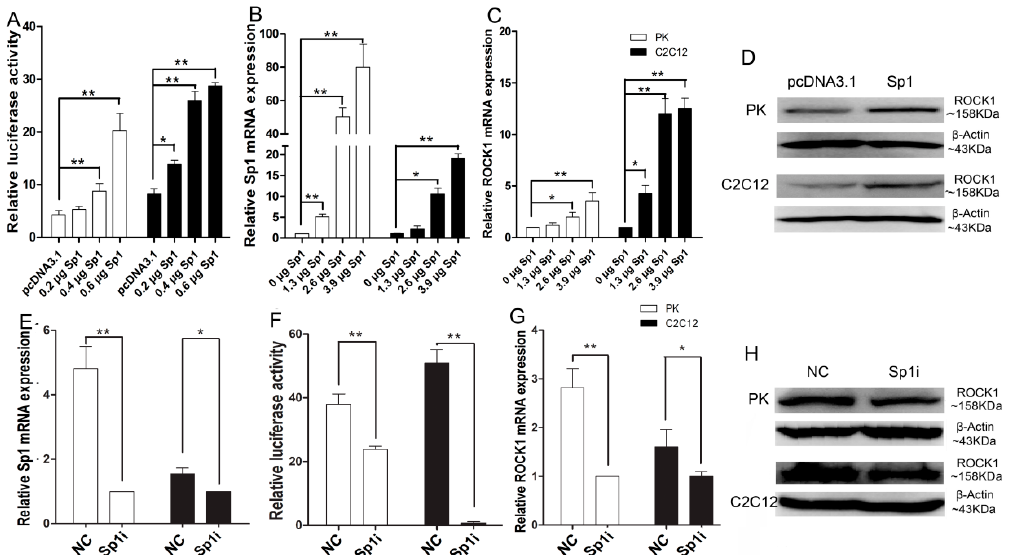
Figure 4. Sp1 stimulates the expression of porcine ROCK1 gene. ( A ) Over-expression of Sp1 up-regulated ROCK1 luciferase activity; ( B ) Over-expression efficacy of Sp1; ( C , D ) Over-expression of Sp1 stimulated ROCK1 expression at mRNA and protein level; ( E ) The interferences efficacy of siRNA; ( F ) Suppressing Sp1 reduced the ROCK1 promoter activity; ( G , H ) Inhibition of Sp1 suppressed ROCK1 expression at mRNA and protein level. The amount of plasmid was kept constant by the addition of pcDNA3.1 (+) vector. The data were obtained both in PK and C2C12 cells and expressed as means ± SD of three replicates. * p < 0.05, ** p < 0.01.